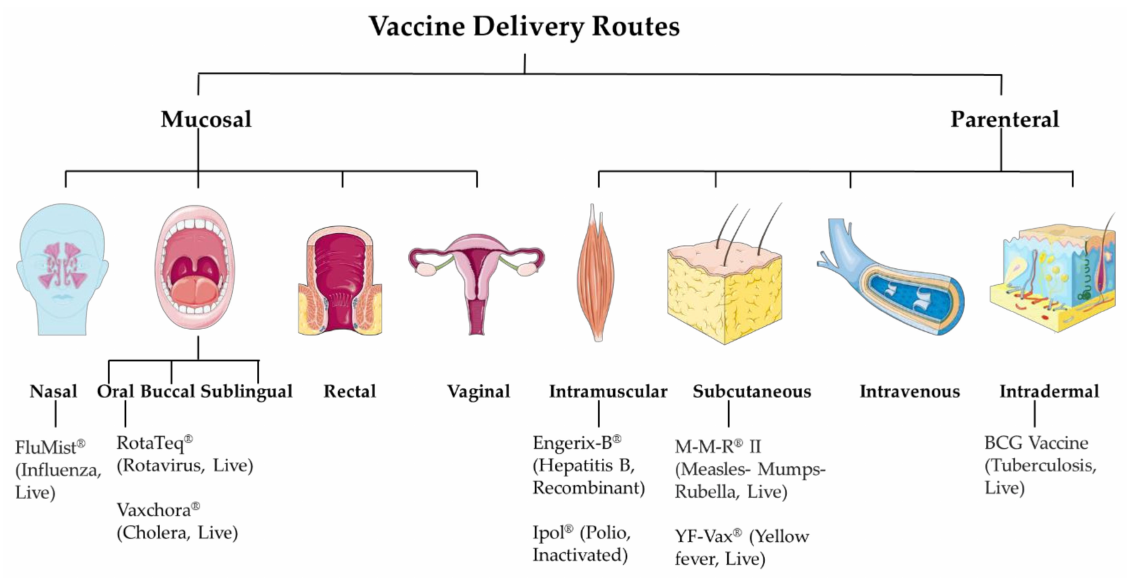
Figure 1. Vaccine delivery